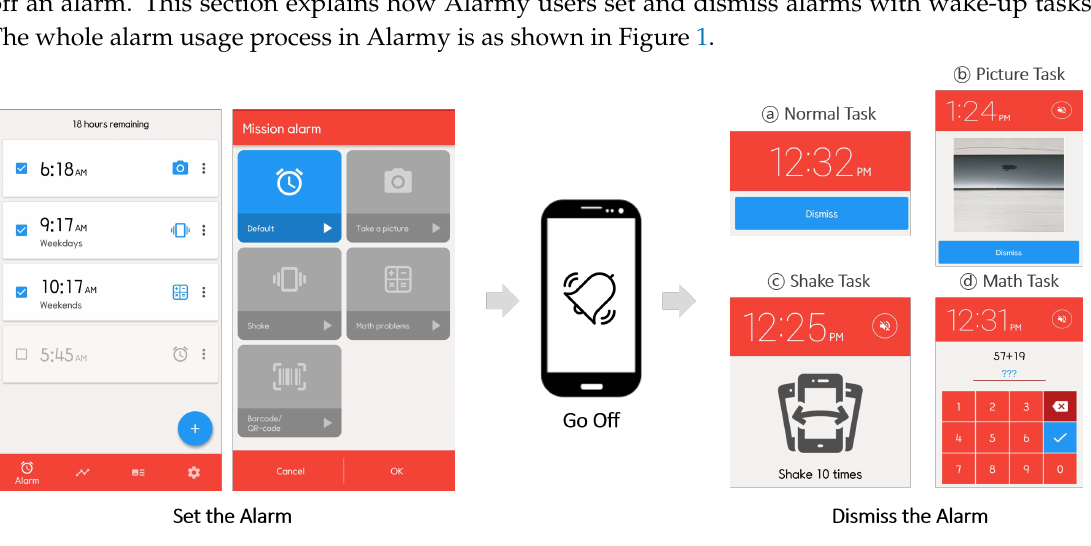
Figure 1. Setting and dismissing an alarm in the Alarmy